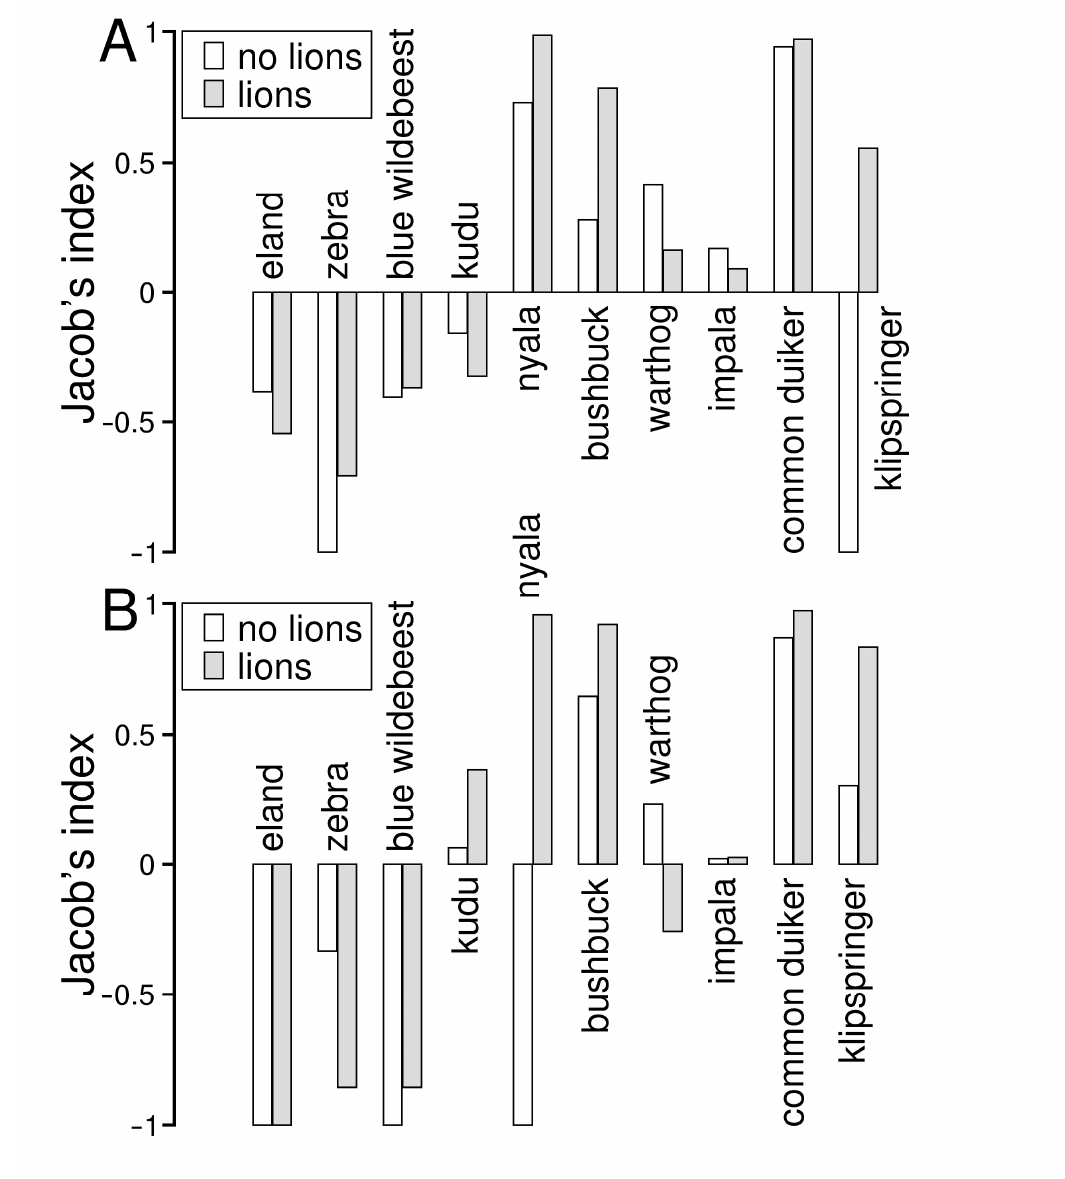
Figure 5. Selection of main prey species, quantified as Jacob’s index, of brown hyaenas ( A ) and leopards ( B ) inareservewithout(Lapalala)andwithlions(Welgevonden). Jacob’sindexrangesfrom − 1, whichindicates strong avoidance, to 1, indicating strong